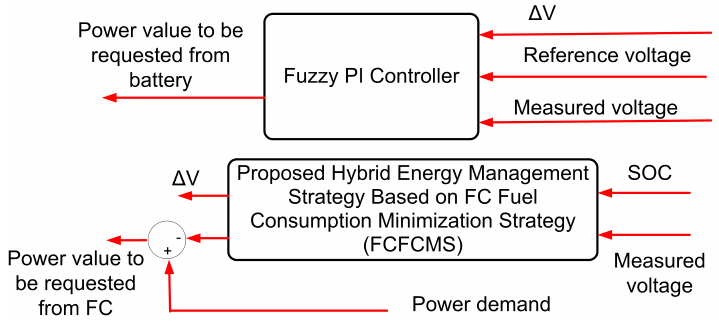
Figure 8. FC Fuel Consumption Minimization Strategy